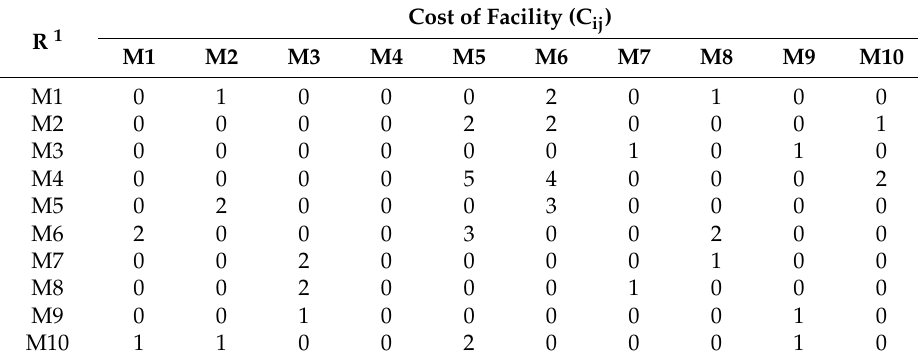
Table 5. Material transportation cost per unit distance.